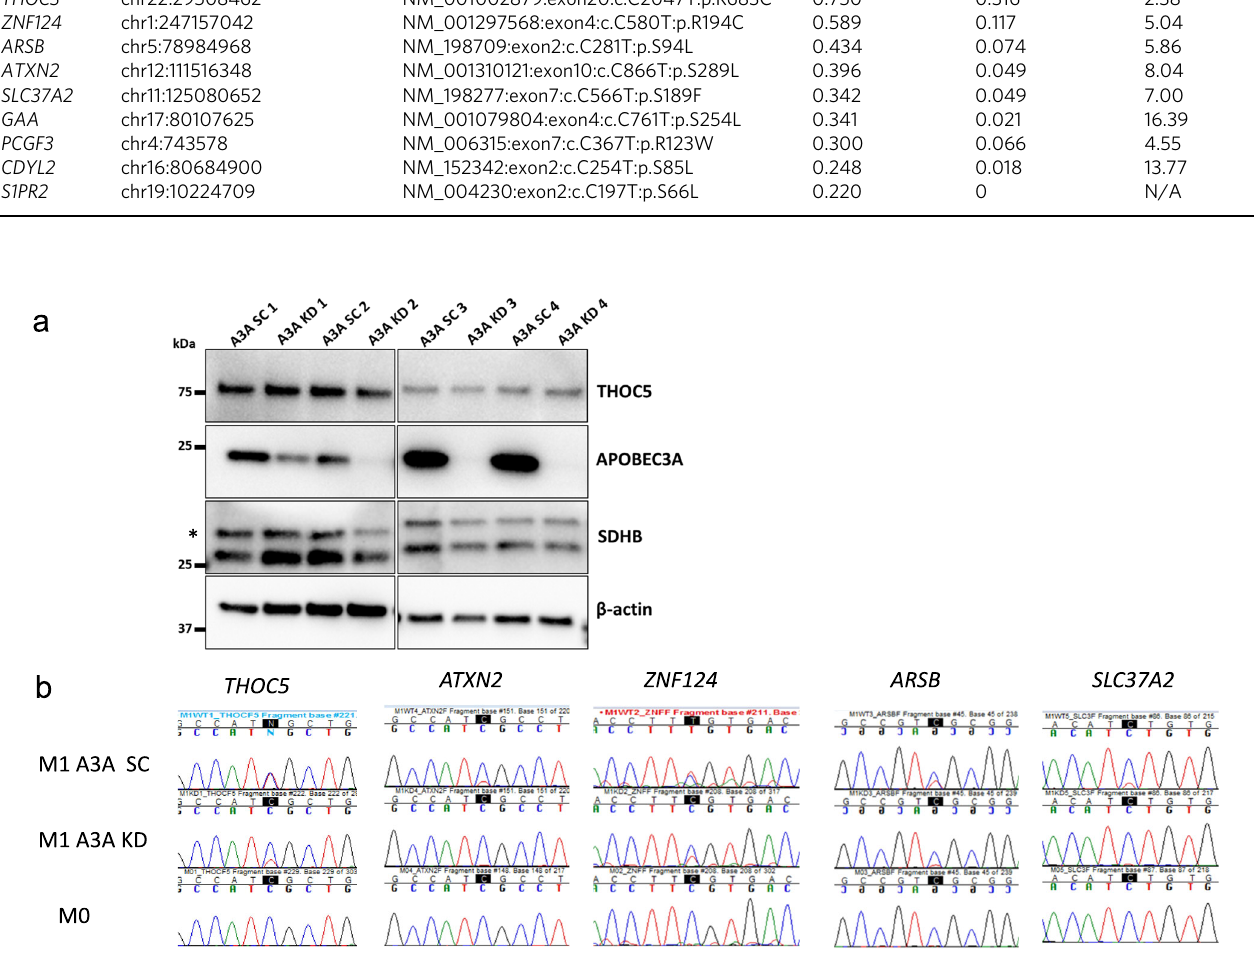
Fig. 4 Knock down of APOBEC3A reduces APOBEC3A protein expression and C>U RNA editing levels in M1 macrophages. a THOC5, APOBEC3A and SDHB (upper band with asterisk) protein levels in whole-cell lysates (20 μ g protein) of M1 macrophages isolated from A3A SC and A3A KD samples from four separate set of donors are shown. Lanes for APOBEC3A and SDHB were run in parallel in the same gel. b Sanger sequencing of selected gene mRNAs con fi rms the induction of RNA editing in M1 A3A SC, which is reduced by A3A KD. Unpolarized M0 samples show no evidence for RNA editing. The edited Cs are highlighted within black